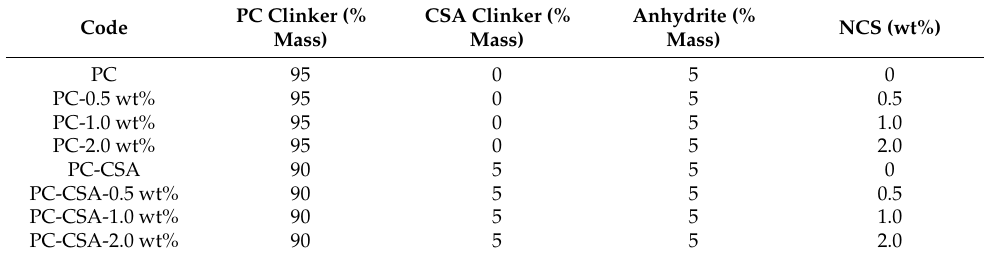
Table 3. Mix proportions of the cement used.